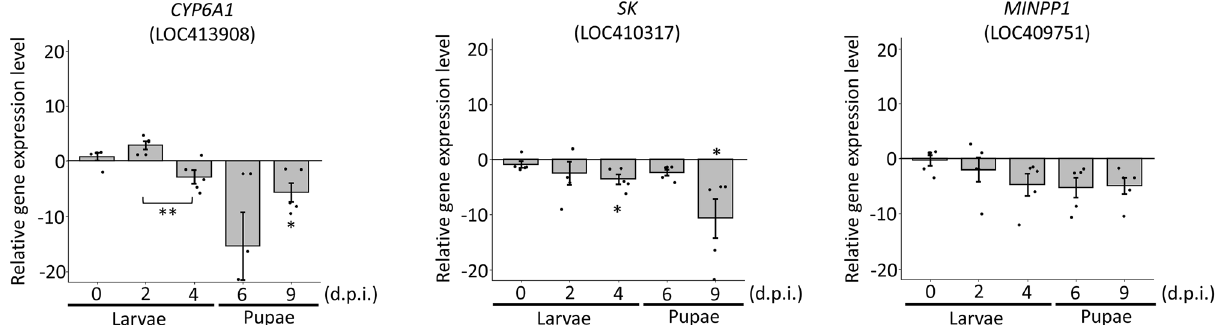
Figure 6. Validation of downregulated genes at 0, 2, 4, 6 and 9 d.p.i. The mean ± SD was calculated for relative gene expression levels using the 2 −ΔΔCt method (Livak &Schmittgen 2001). All experiments were performed in five replicates. * P < 0.05; **P <